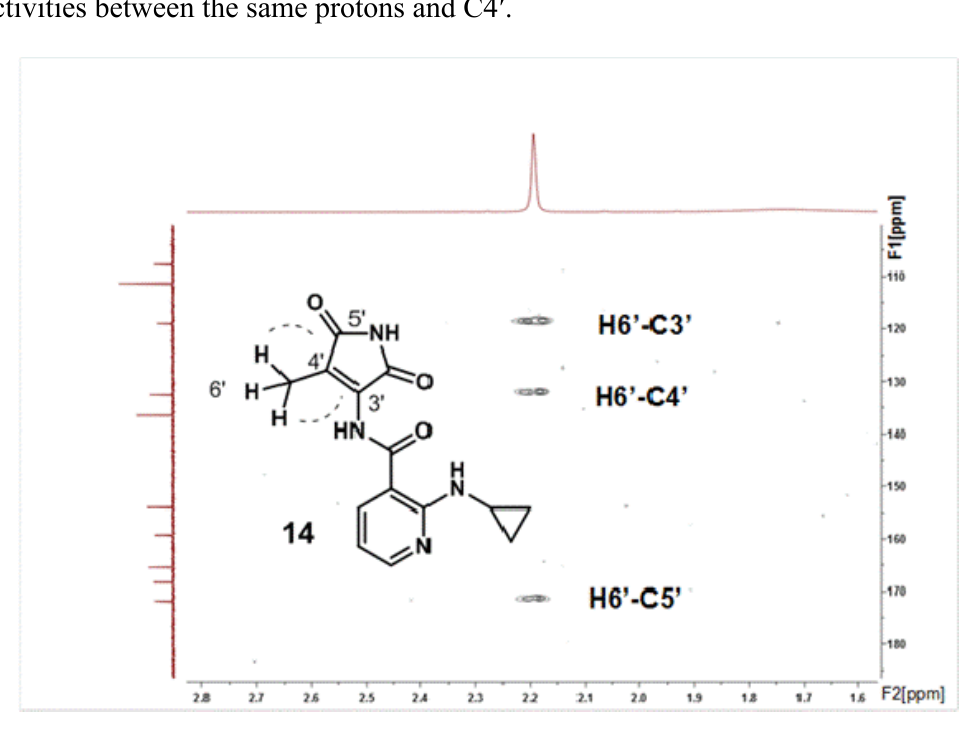
3-bond connectivities between the methyl protons (H6 ′ ) and C5 ′ and C3 ′ , and the 2-bond connectivities between the same protons and C4 ′